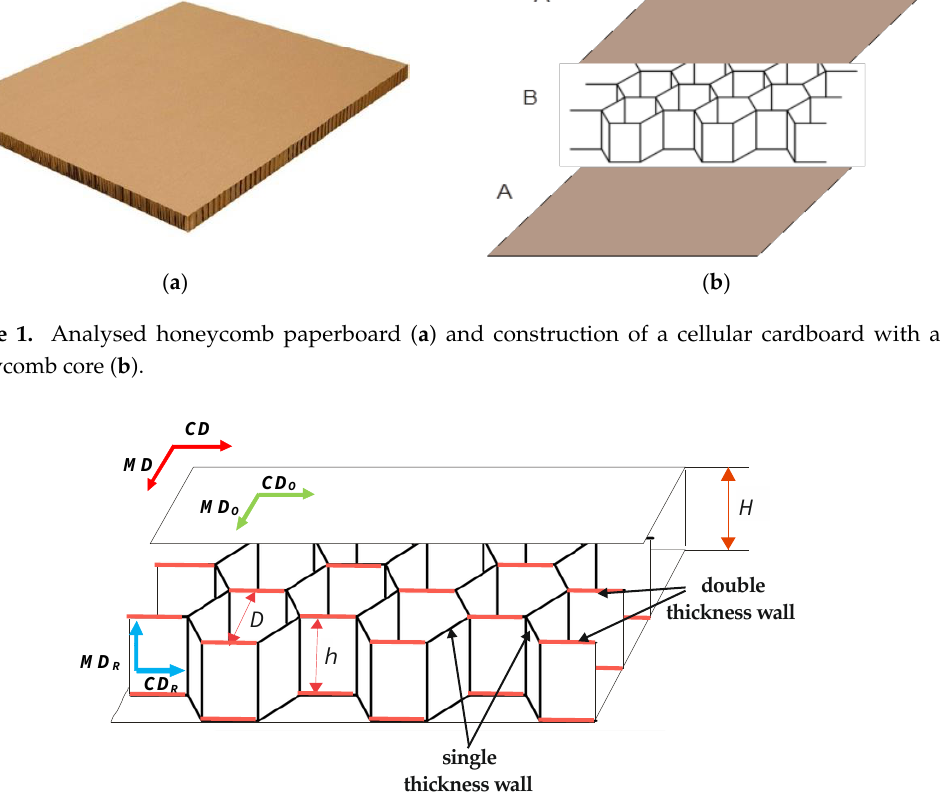
Figure 1. Analysed honeycomb paperboard ( a ) and construction of a cellular cardboard with a honeycomb core ( b ).